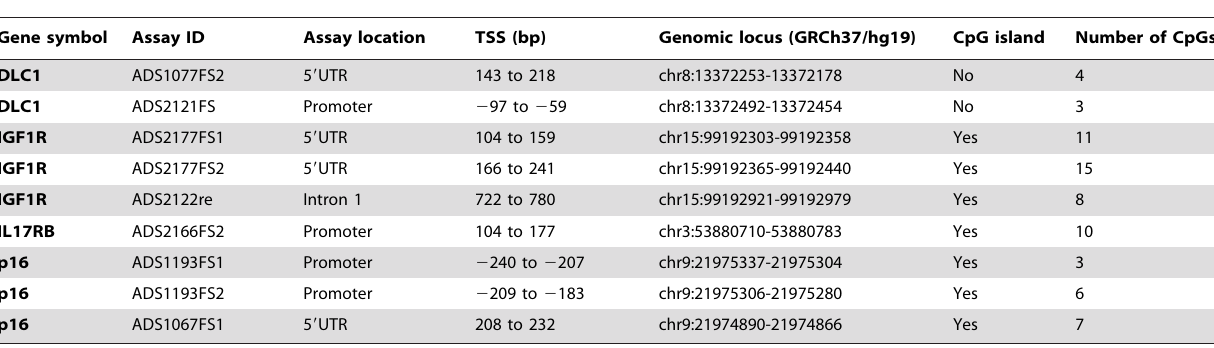
Table 1. Summary of assay details for CpG sites interrogated by bisulfite pyrosequencing.